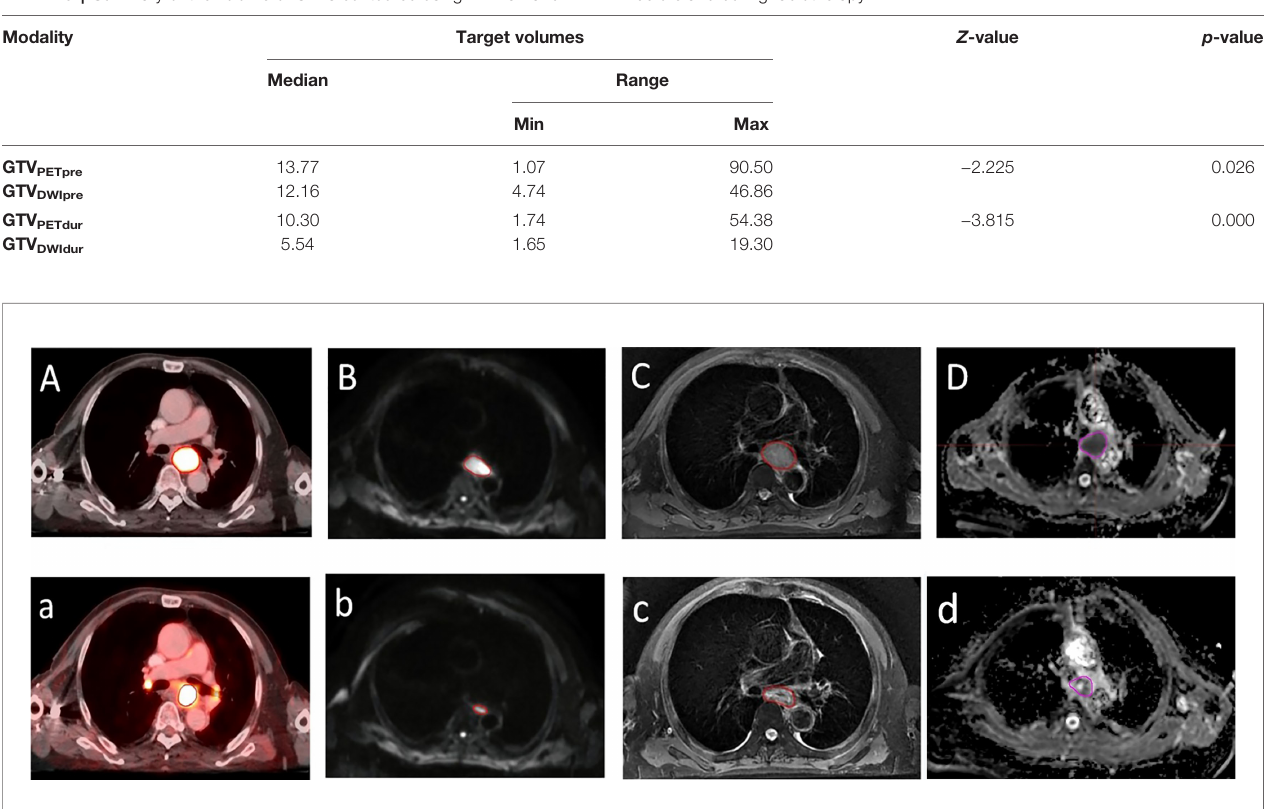
FIGURE 2 | A transversal diagram of gross target volumes on esophageal cancer with high uptake on 18 F fl uorodeoxyglucose positron emission tomography/ computed tomography fused images. (A,a) Corresponding tumor on T 2 -weighted imaging (C,c) with a high signal on diffusion weighted magnetic resonance imaging (b=600 s/mm 2 ) (B,b) and corresponding apparent diffusion coef fi cient map (D,d) with restricted diffusion at the location of the tumor before radiotherapy (A – D) and during radiotherapy (a – d)